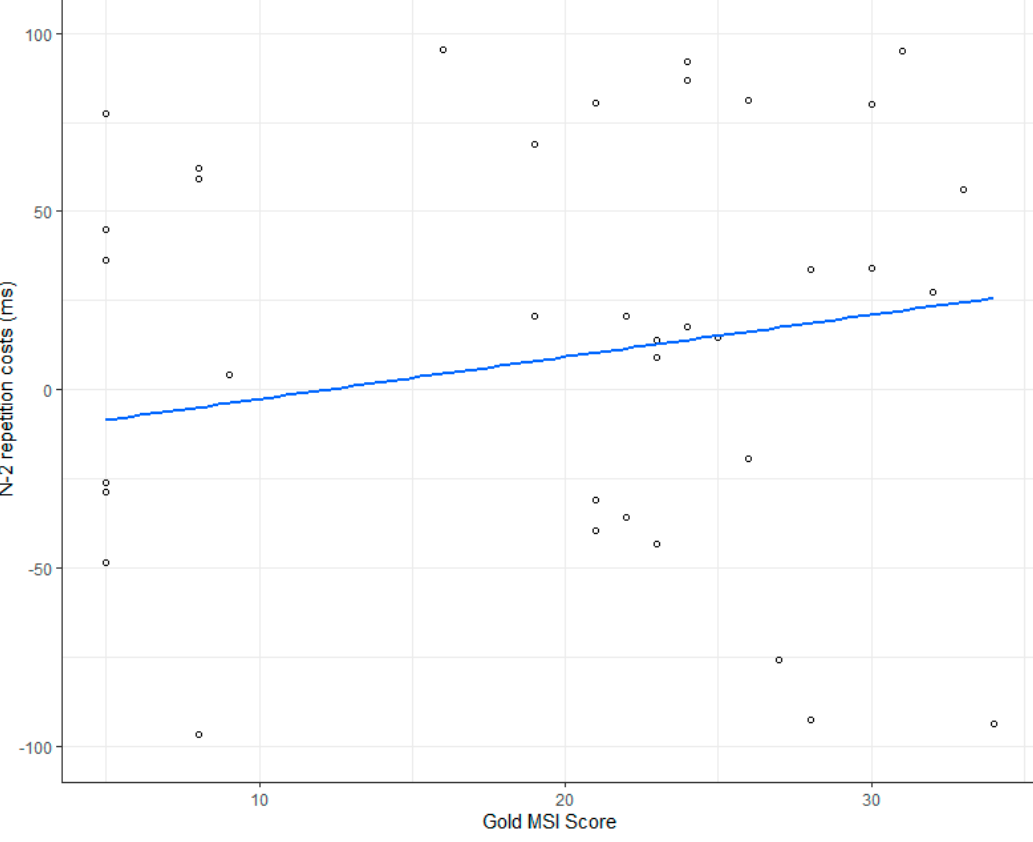
Figure 3. N-2 repetition costs (ms) by Gold MSI score obtained. The blue line is the fitted regression line.